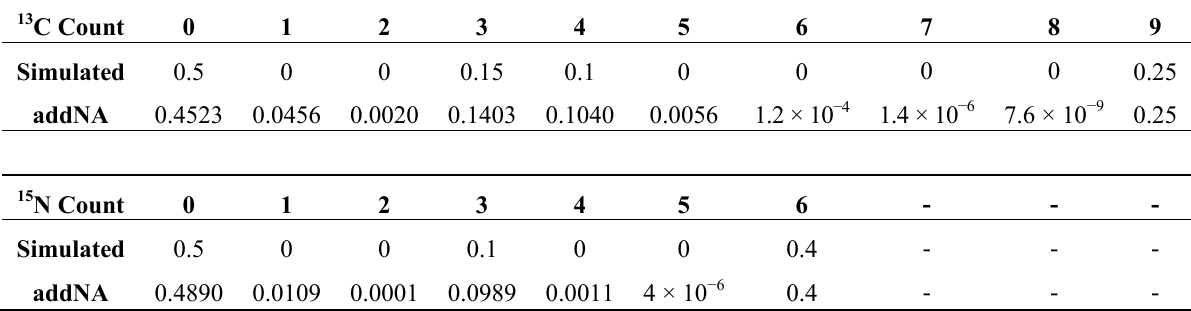
Table 2. Simulated 13C and 15N single-isotope isotopologue intensity datasets.